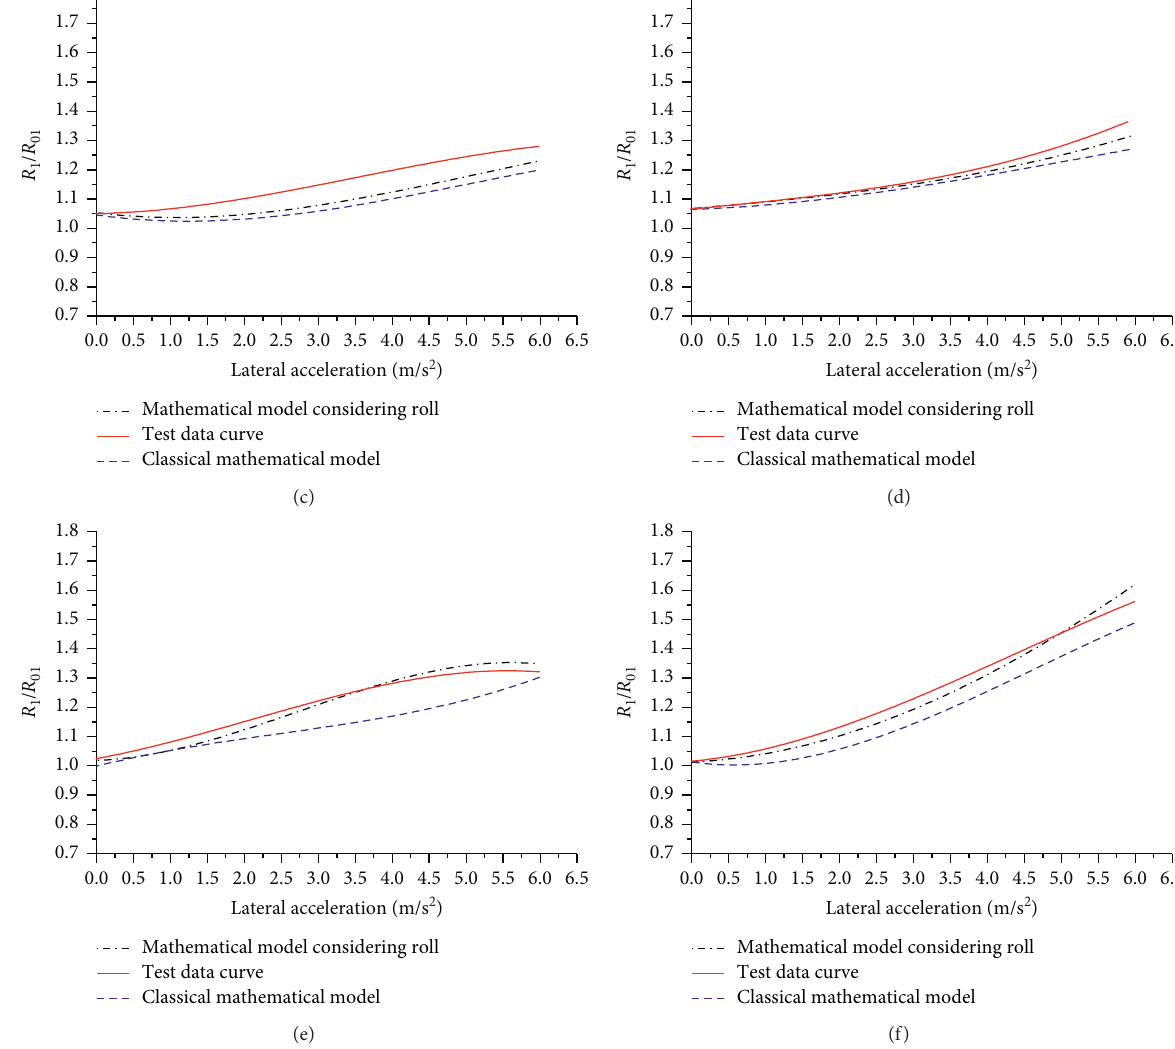
Figure 9: Curves for the turning radius ratio from the tests and simulations using the proposed and classical mathematical models. (a, b) Turning radius ratio of the tractor and trailer of semitrailer I, respectively. (c, d) Turning radius ratio of the tractor and trailer of semitrailer II, respectively. (e, f) Turning radius ratio of the tractor and trailer of semitrailer III,